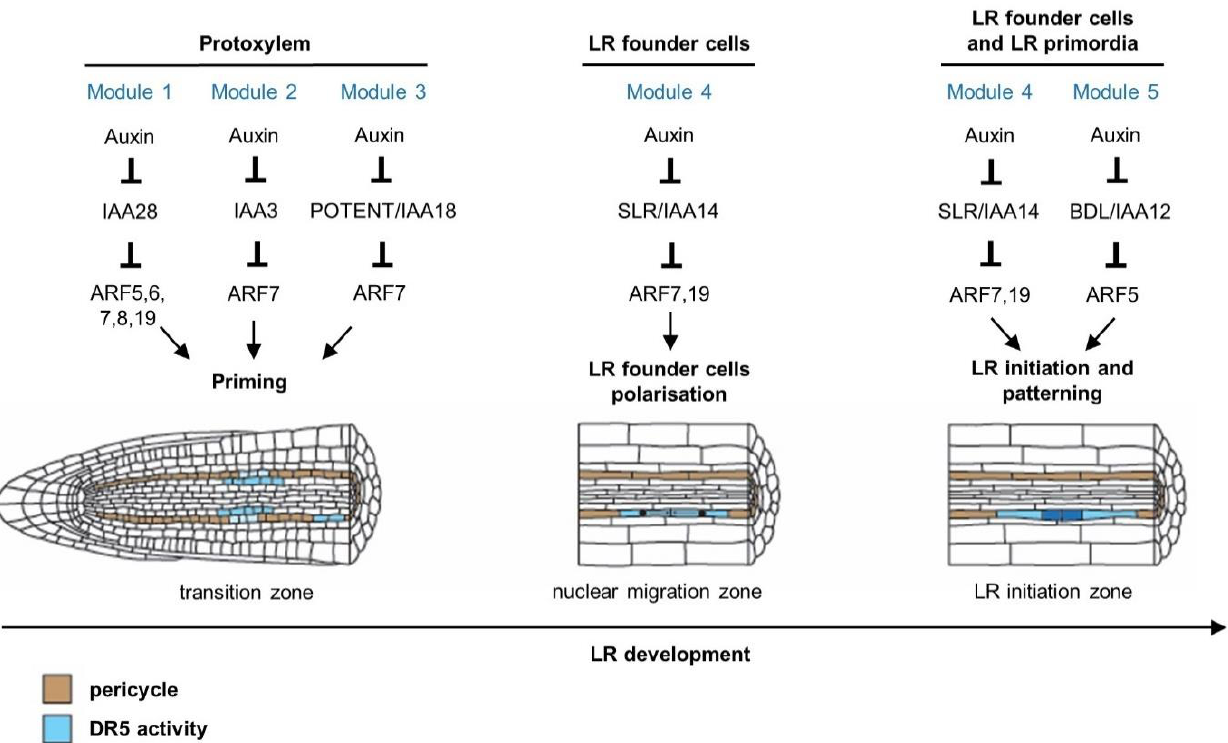
Figure 2. Auxin regulates different stages of lateral root development through multiple auxin-signalling modules in Arabidopsis . Lateral root founder cell priming involves the IAA28–ARF5, 6, 7, 8, 19, IAA3-ARF7 and POTENT/IAA18-ARF7 module (Modules 1, 2 and 3, respectively) in the basal meristem [11,31,32]. After priming, cells at prebranch sites maintain an increased auxin response, which was revealed through analysis of the pDR5:LUCIFERASE reporter [28,33–35]. Lateral root founder cells start to accumulate auxin, which triggers their polarisation and subsequent lateral root initiation [11]. The IAA14/SOLITARY-ROOT–ARF7-ARF19 module (Module 4) regulates the polarisation of lateral root founder cell pairs, which leads to coordinated nuclear migration towards the common cell walls [11,36]. Both the IAA14/SLR–ARF7,19 and the IAA12/BDL–ARF5 modules (Modules 4 and 5, respectively) are necessary for triggering lateral root initiation, which starts with an asymmetric anticlinal division of lateral root founder cells [37–39]. These modules also regulate the morphological and histological patterning of the LRP [26,40,41]. Cells coloured in blue indicate auxin response according to the synthetic DR5 reporter. Cells coloured in brown belong to the pericycle.